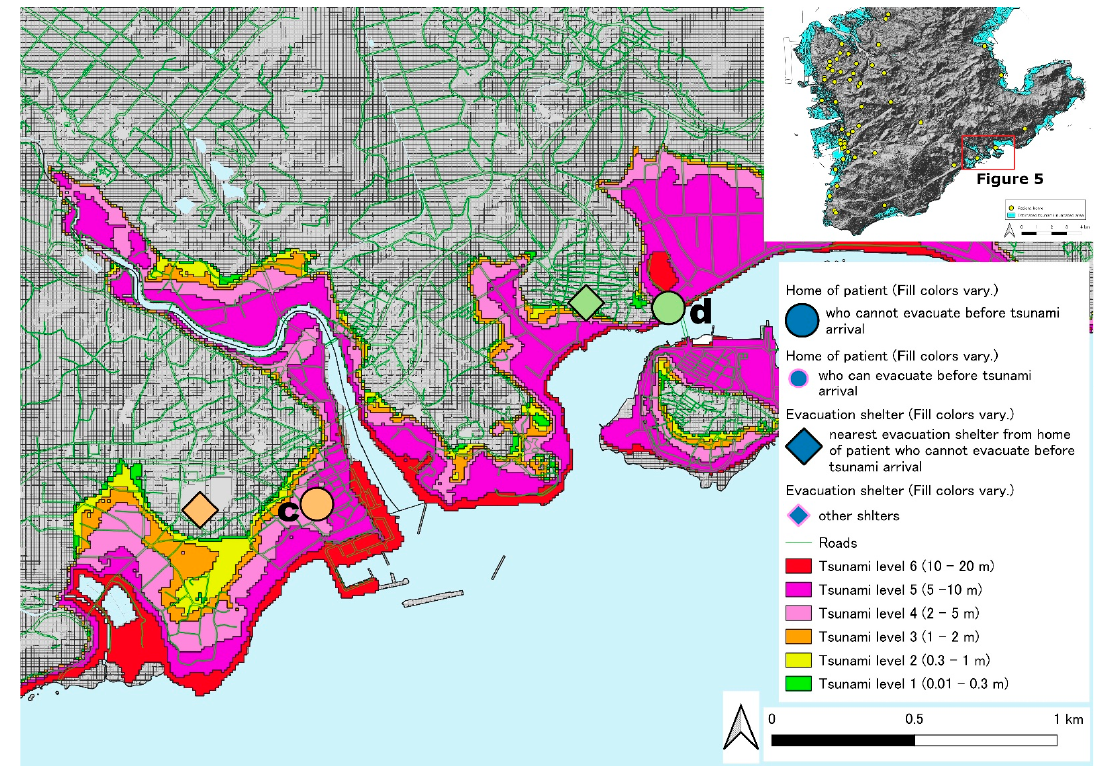
Figure 5. The locations of patients with chronic respiratory diseases with HOT who live near the coastline containing an islet on the southeast side of the southern part of the main island of